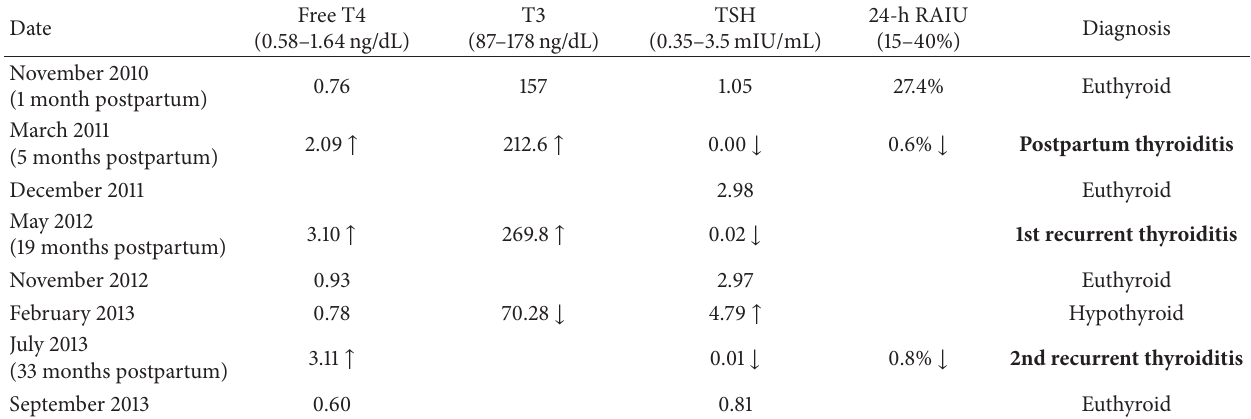
Table 1: Temporal profile of thyroid function test and thyroid uptake scan for the patient reported to be having recurrent